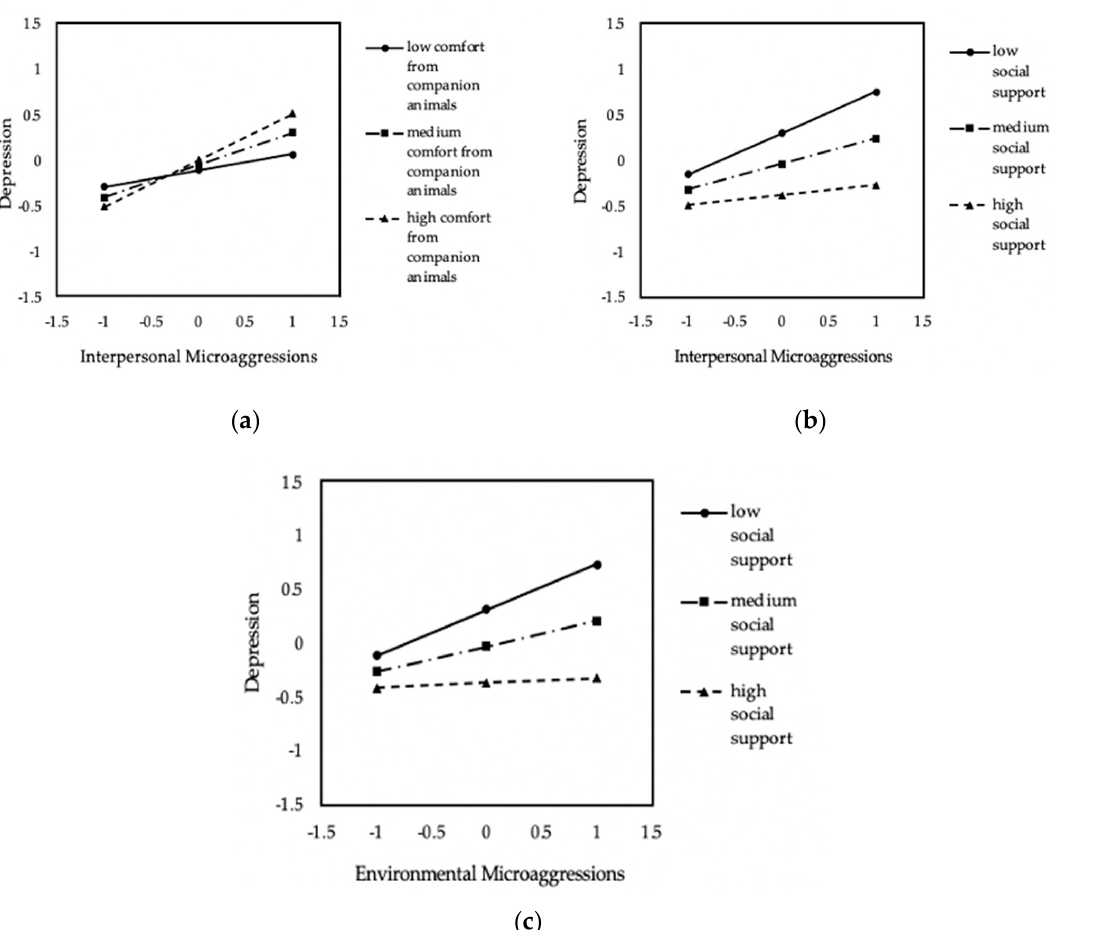
Figure 2. Significant conditional effects of simple moderation ( n = 134). ( a ) Conditional effect of interpersonal microaggressions on depressive symptoms as a function of comfort from companion animals; ( b ) conditional effect of interpersonal microaggressions on depressive symptoms as a function of social support; ( c ) conditional effect of environmental microaggressions on depressive symptoms as a function of social support. All the variables of interest were standardized .